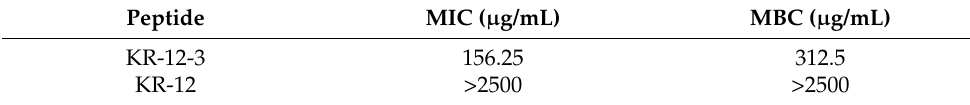
Table 3. In vitro susceptibility of S. gordonii to KR-12-3 and KR-12.